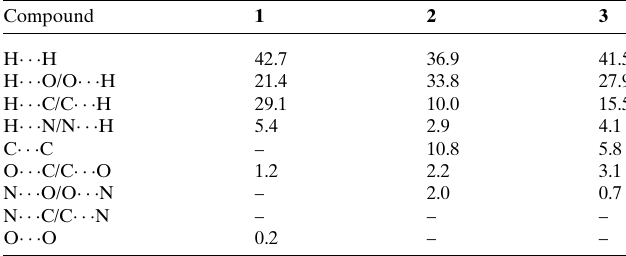
Table 4 Percentages of atom–atom contacts for compounds 1 – 3